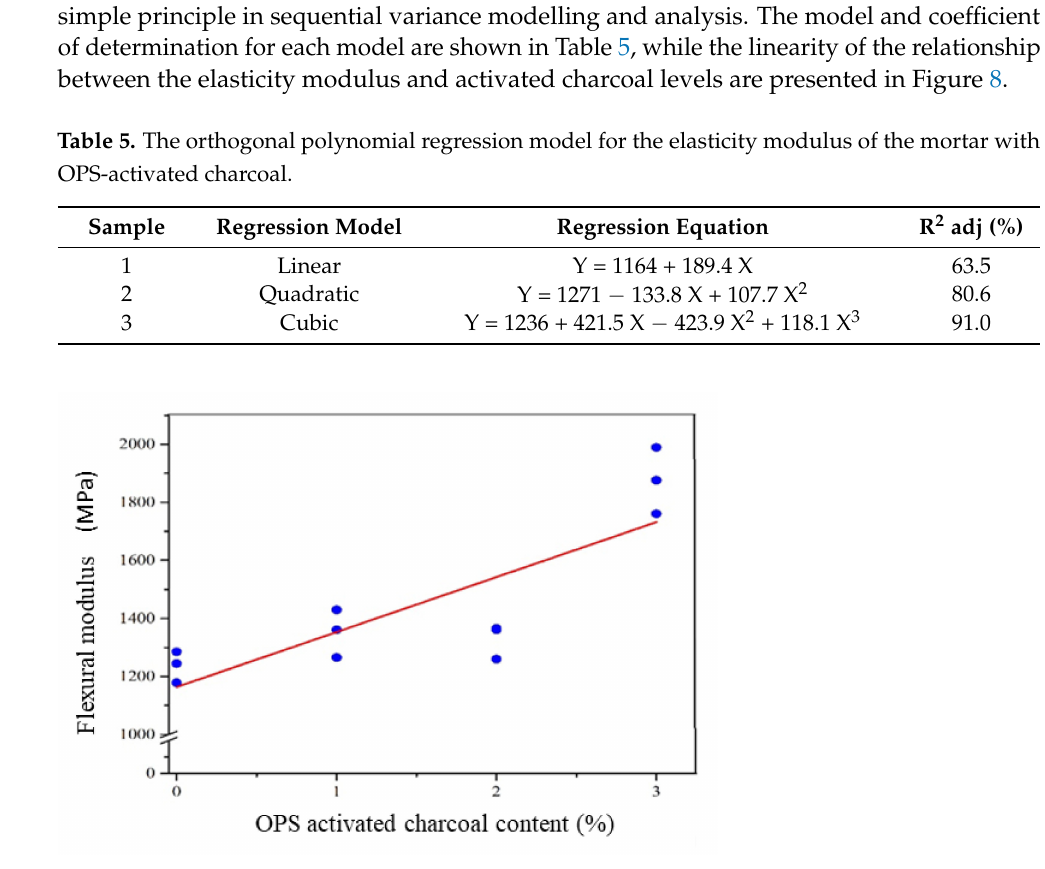
Figure 8. The linear model of the relationship between the elasticity modulus of the mortar and activated charcoal